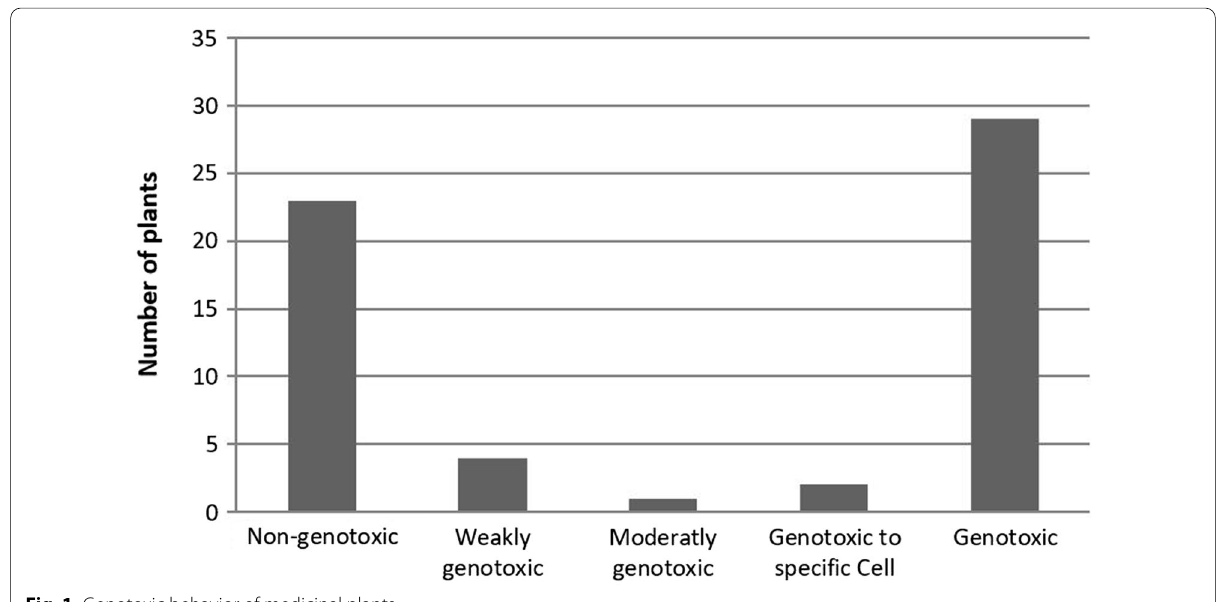
Fig. 1 Genotoxic behavior of medicinal